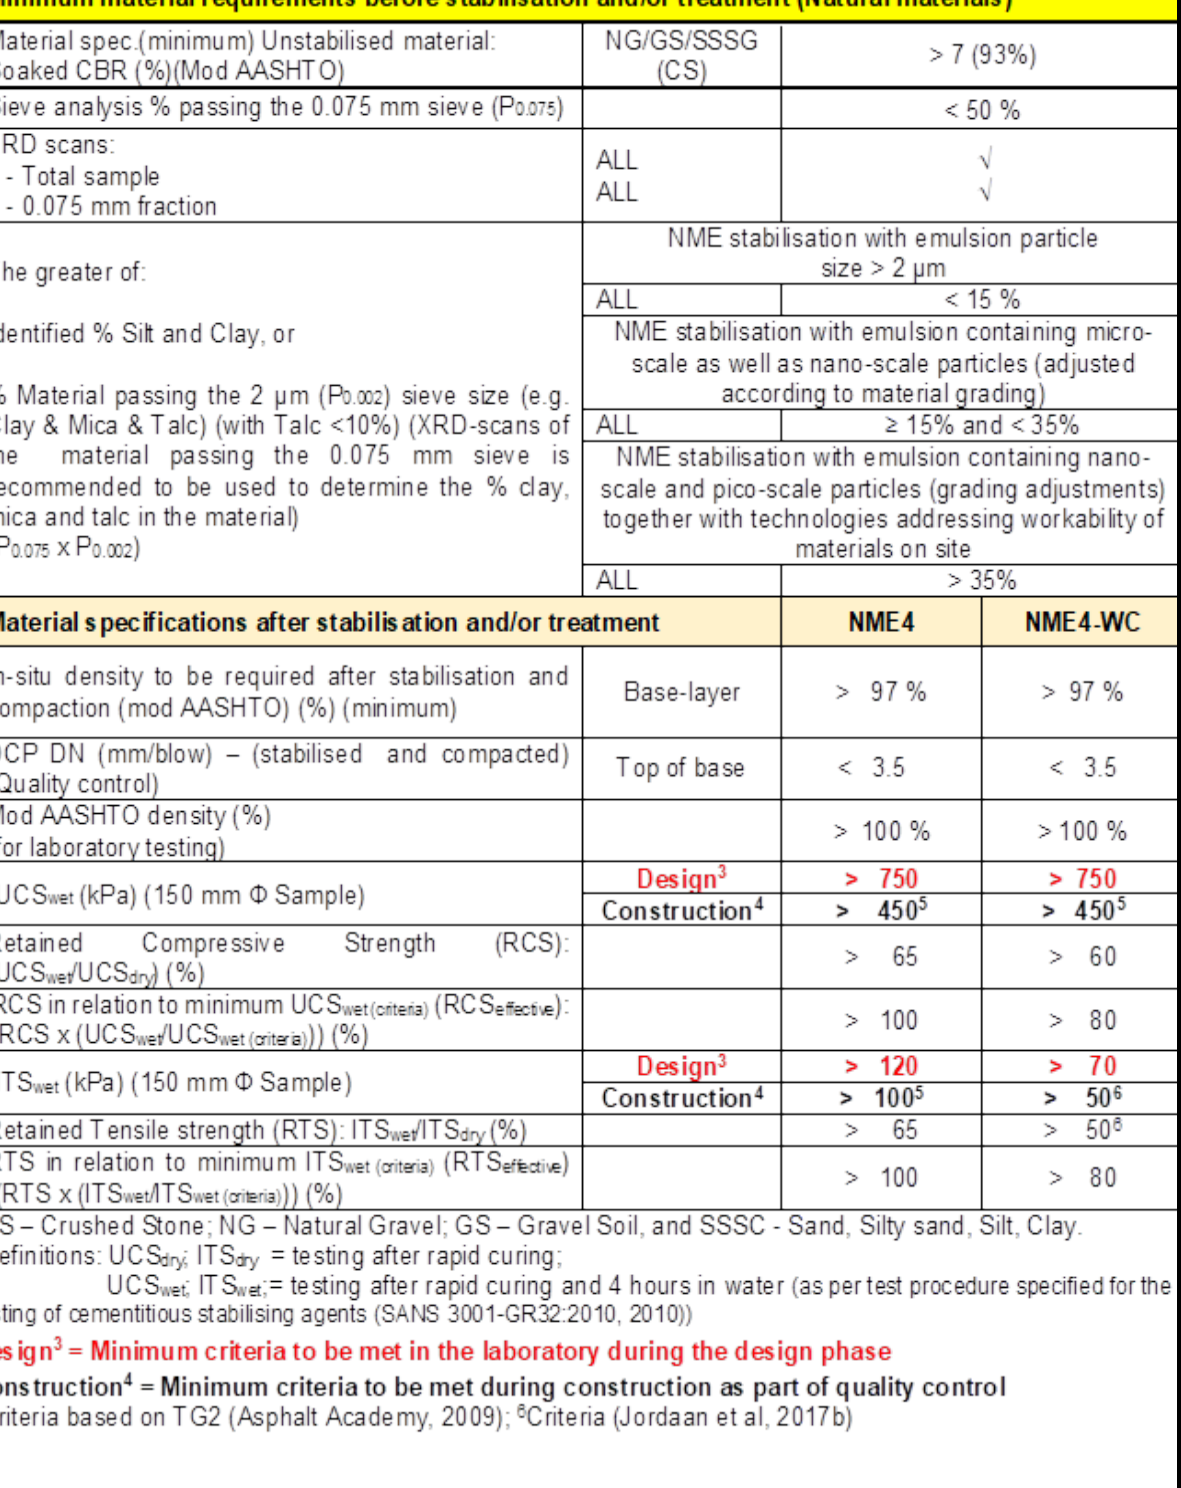
Figure 4. Reference [27]: Minimum recommended standard specifications for New-age (Nano) Modified (NME) stabilised materials, addressing Low-volume Roads (LVR) and access roads to remote communities as well as in villages/townships.